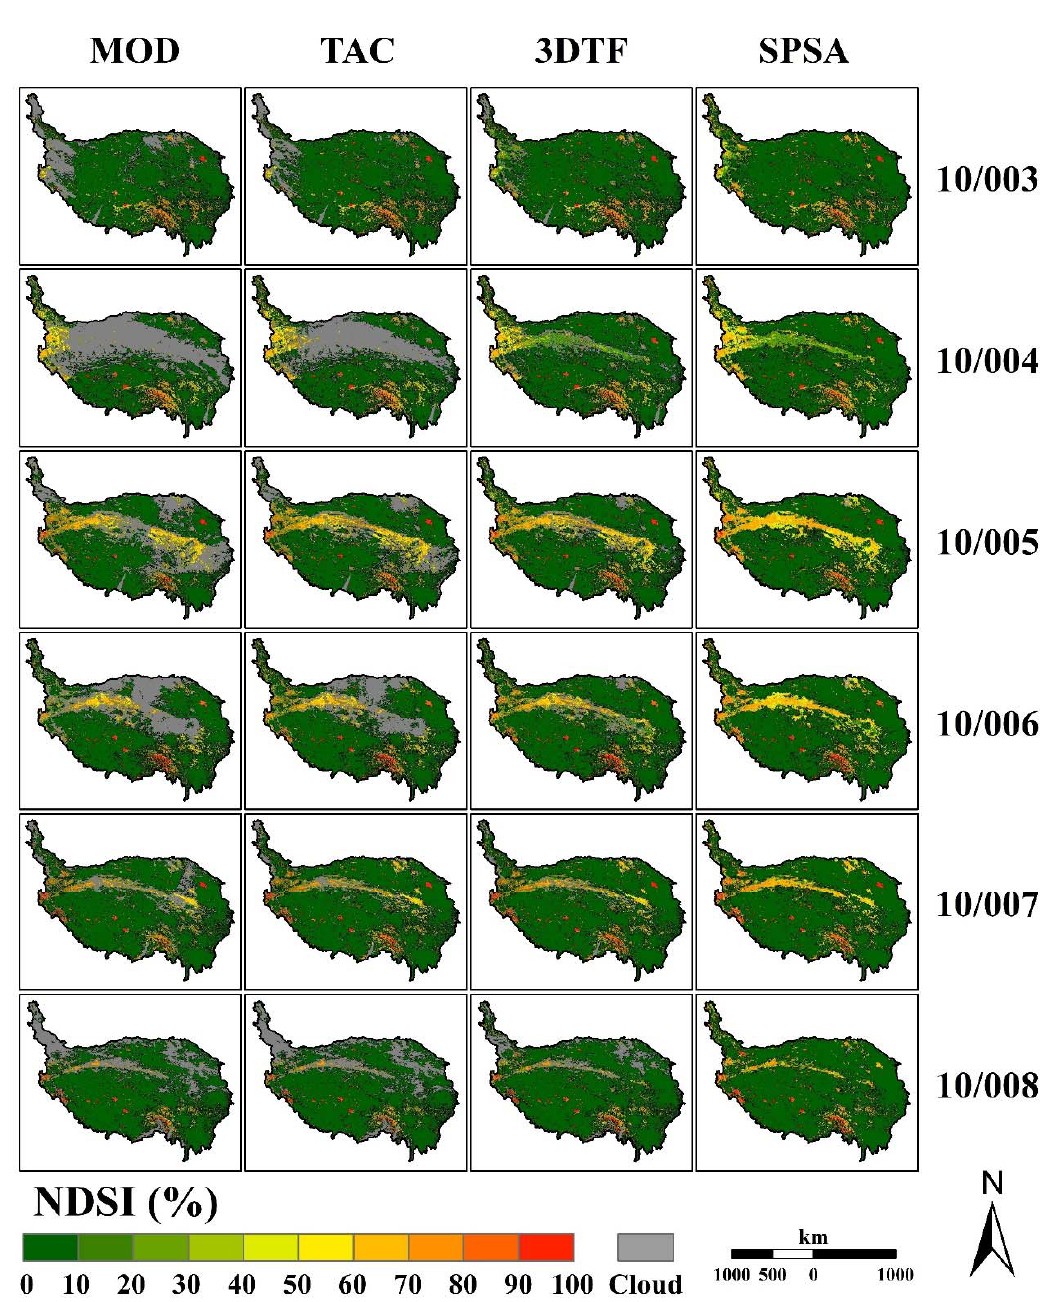
Figure 12. Time series of the NDSI maps after the TAC, 3DTF, and SPSA gap-filling steps. The time series begins on 3 January 2010 and ends on 8 January 2010.